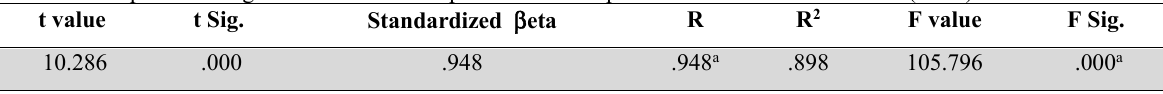
Results of simple linear regression to test the impact of ownership concentration effect on assets (ROA) indicator . value t Sig. t